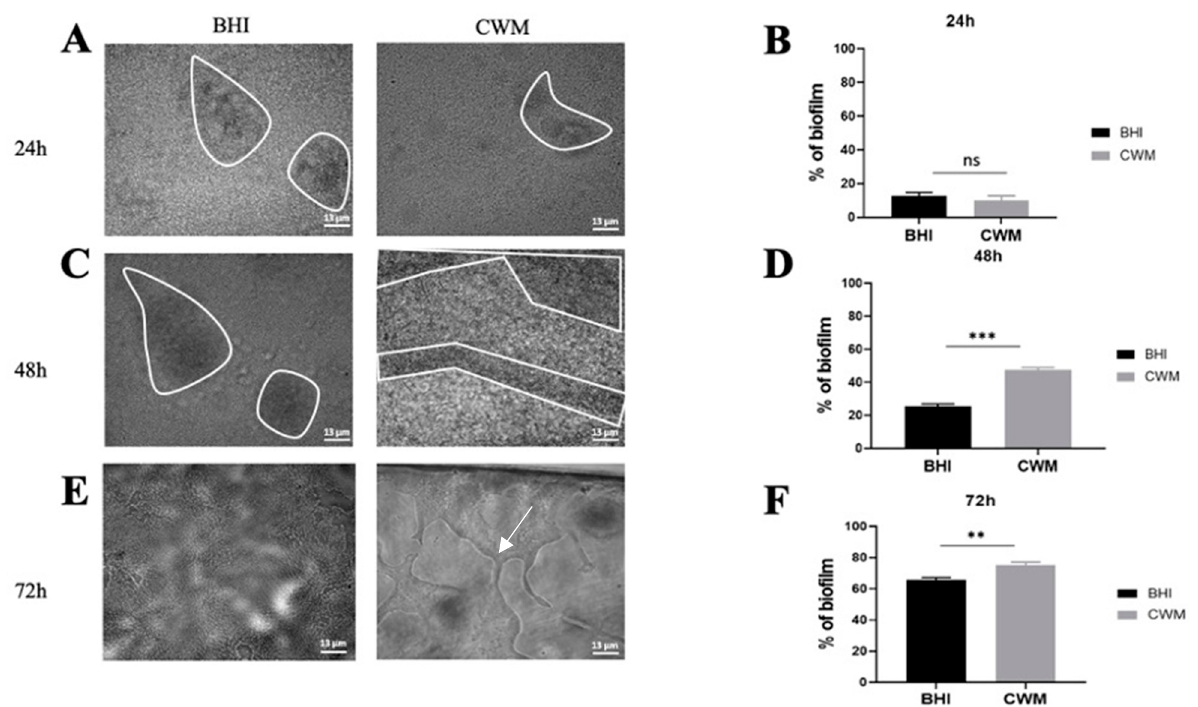
Figure 3. Kinetics of biofilm formation of Pseudomonas aeruginosa PAO1 in the BioFlux TM system. ( A , C , E ) correspond to representative images taken at different times (( A ) 24 h; ( C ) 48 h and ( E ) 72 h) of biofilm formation in the CWM and BHI media. The images are the result of one of the three experimental triplicates. Biofilm is visualized by the black part in between the white lines. Percentages of biofilm formation are presented at 24 h ( B ), 48 h ( D ) and 72 h ( F ) postincubation in both media after three independent experiments. They were determined by the ImageJ software application. The white arrow indicates the presence of the exopolysaccharides structures formed by P. aeruginosa during biofilm formation. Results are presented as the mean ± standard deviation. Statistics were performed using a t -test on GraphPad Prism version 7. Ns, p > 0.05; ** p < 0.01; *** p < 0.001.